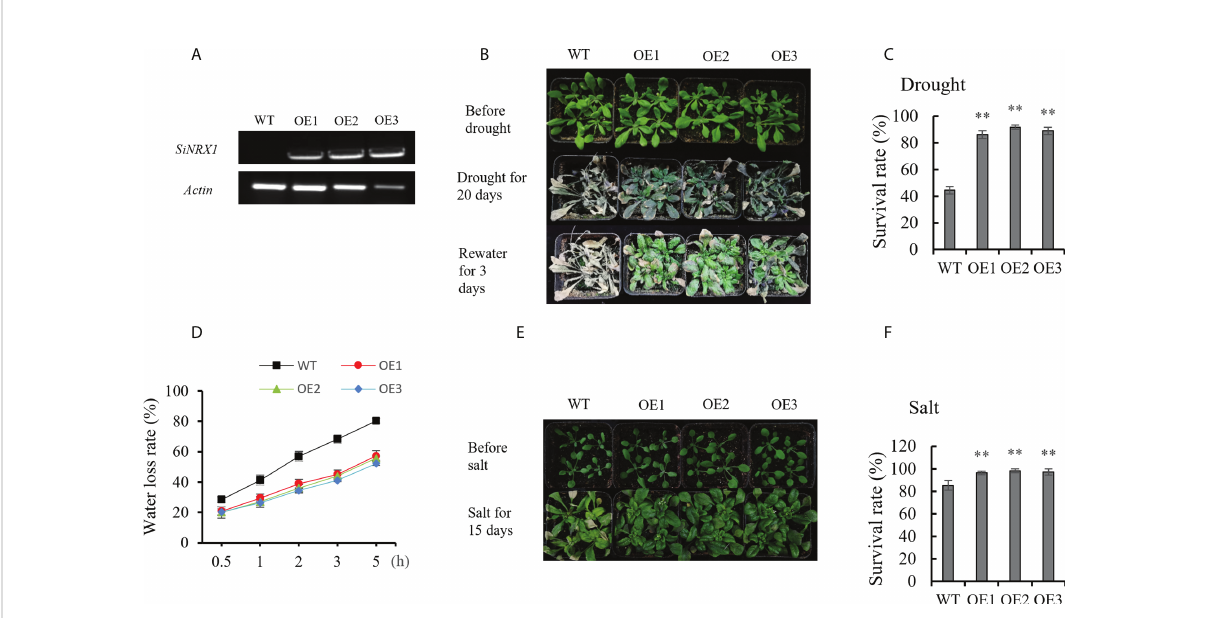
FIGURE 5 The phenotype analysis of OE lines and WT under drought and salt stresses. (A) Gene veri fi cation of SiNRX1 in OE lines by PCR. (B) The phenotype of OE lines after drought treatment for 20 days. (C) The survival rate of OE lines and WT after water withholding for 20 days. (D) The water loss rate of leaves in vitro measured at 25°C. (E) The phenotype of OE lines and WT after salt treatment (150 mM NaCl) for 15 days. (F) The survival rate of OE lines and WT after salt treatment for 15 days. OE: SiNRX1 transgenic Arabidopsis lines; WT: wild-type Arabidopsis lines. Standard deviations are indicated by error bars (mean ± SD and n = 3). Student ’ s t-test was used to calculate signi fi cance: ** indicates p >